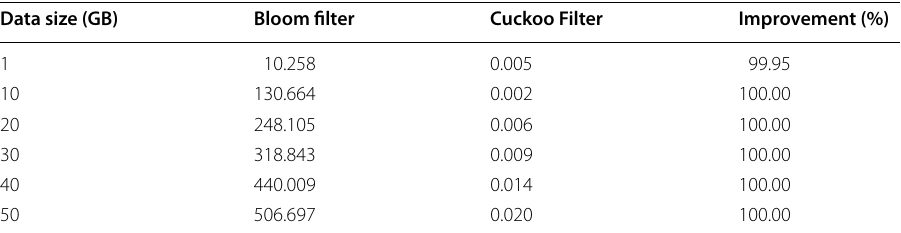
Table 3 Experimental results 1: Lookup performance after deletion for varying data size. Query execution time in